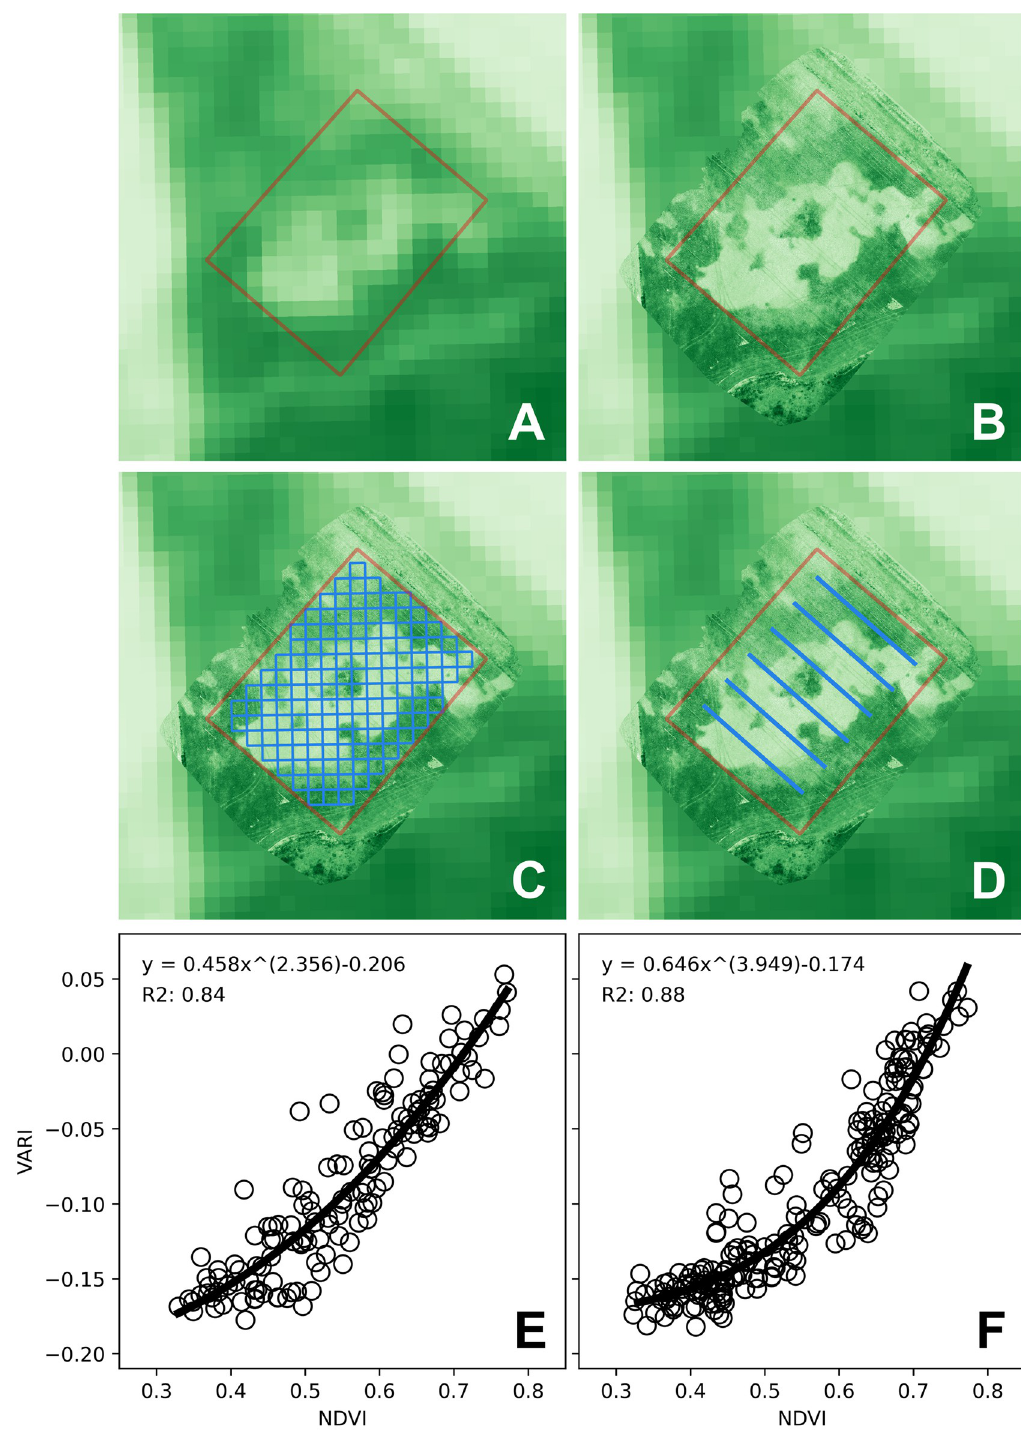
Fig 4. Comparison between data obtained with the OSDT and data obtained from satellite imagery and a handheld sensor. A) NDVI satellite image from Sentinel 2; B) VARI image from drone orthomosaic; C) VARI drone image showing the 10x10m areas equivalent to the satellite image pixels delimited in the processed orthomosaic; D) transects used for measurement with hand-held sensor; E) relationship between NDVI from the satellite image and VARI from the drone; and F) relationship between NDVI from the hand-held sensor and VARI from the drone. Satellite image data was retrieved from Sentinel Hub EO Browser under a CC-BY 4.0 license [45].